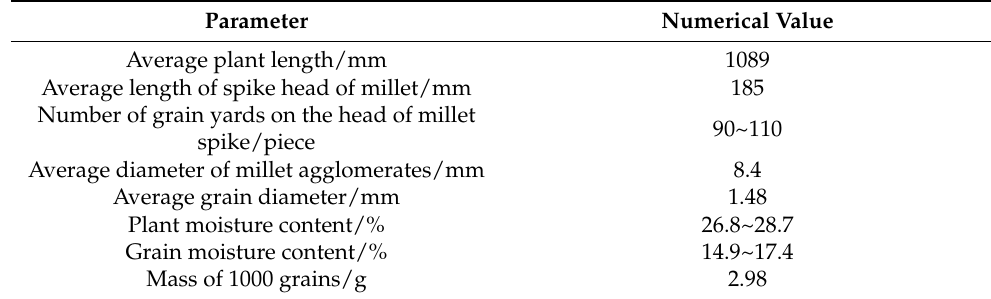
Table 1. Basic parameters of the experimental millet.